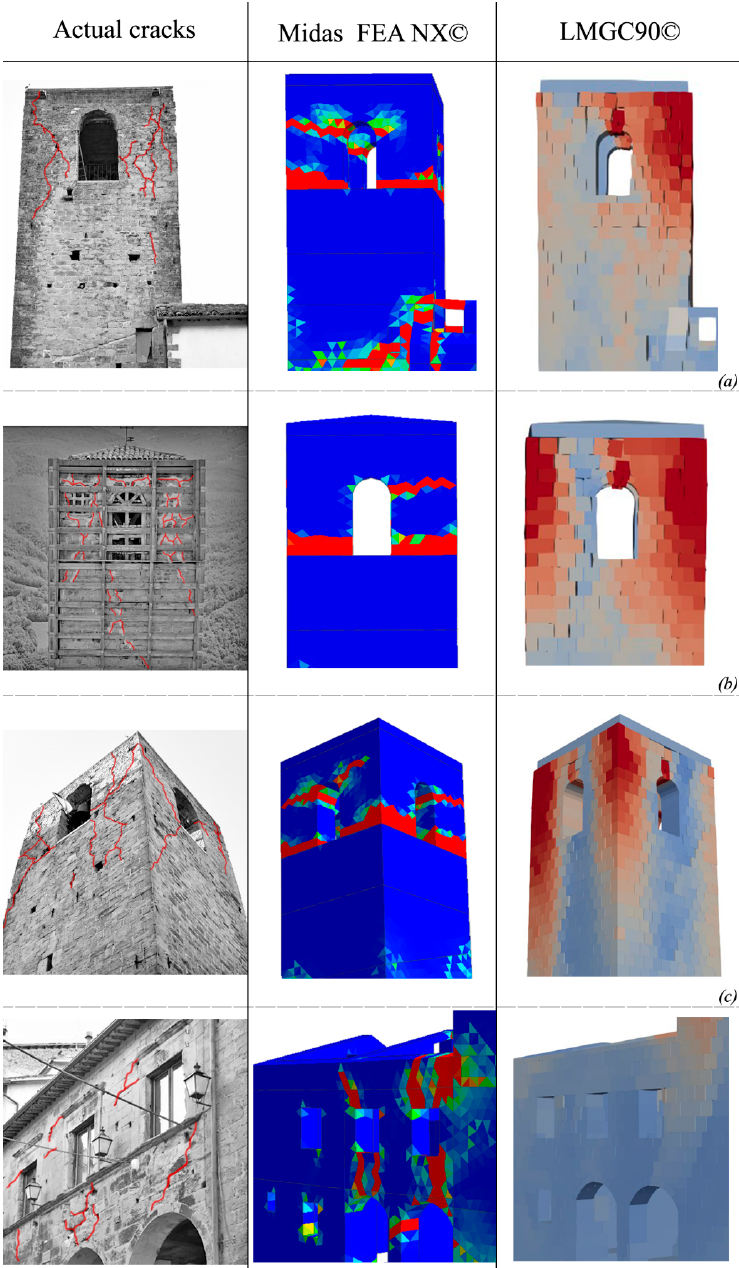
Figure 12. Comparison of the actual cracks and the numerical damage, obtained with CM and DM. ( a ) Bell tower north façade; ( b ) bell tower west façade; ( c ) bell tower south-east corner; ( d ) Podestà Palace south façade.